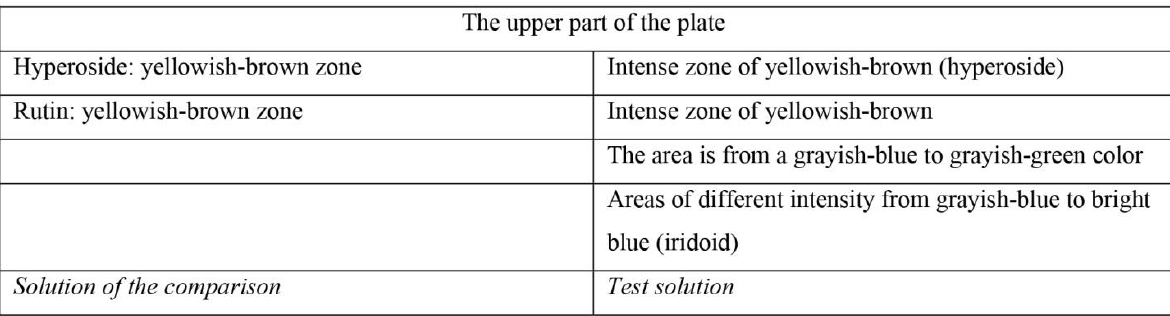
Fig. 1. Diagram of chromatogram of dry extract of Leonurus cardiaca